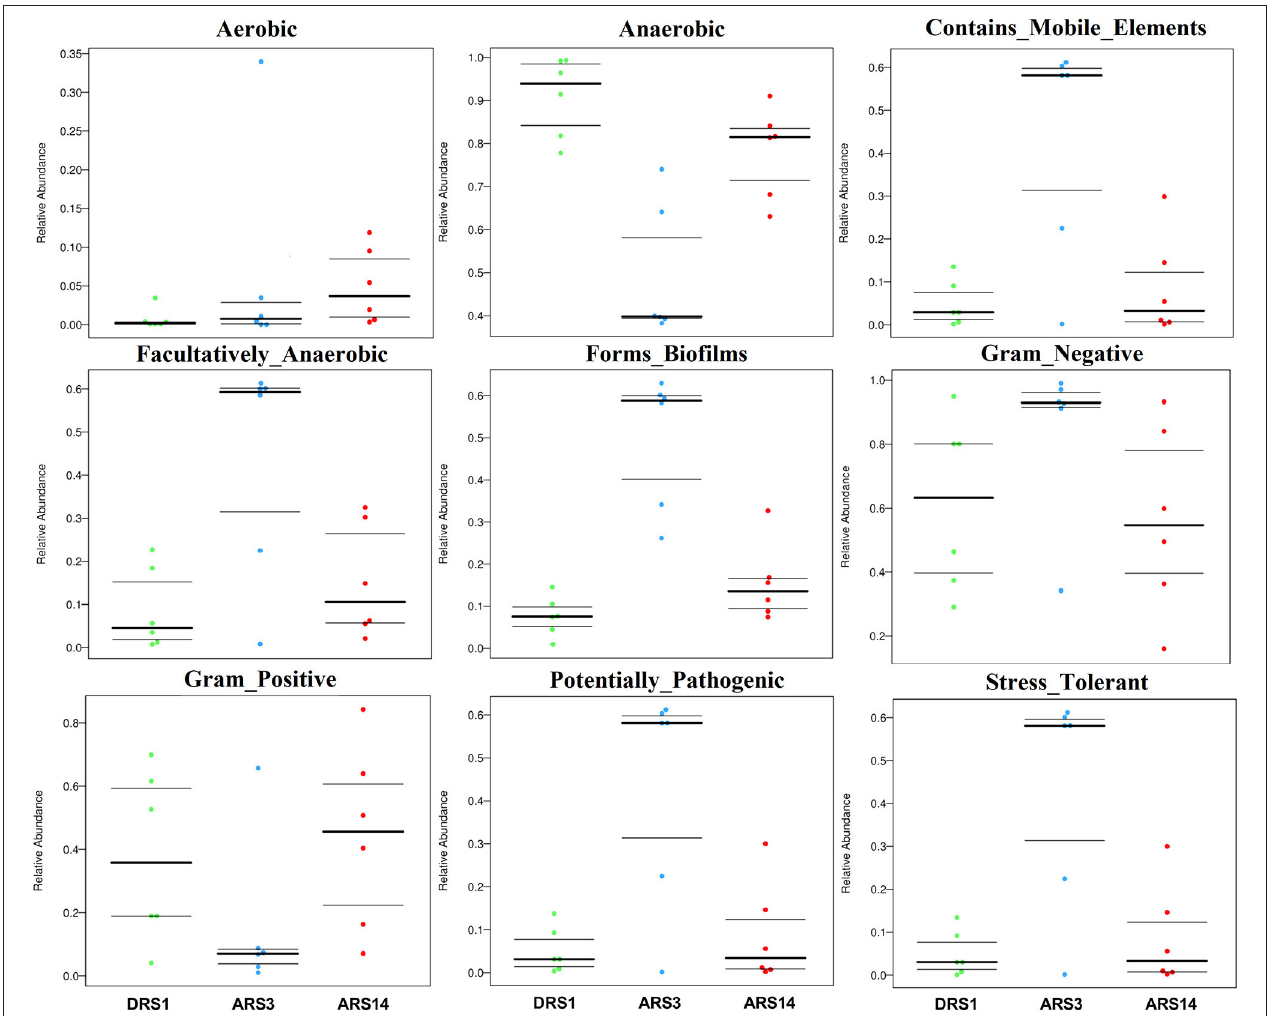
FIGURE 3 | BugBase feature prediction include aerobic, anaerobic facultative anaerobic, contains mobile element content, potential pathogenicity, stress tolerance, forms biofirms and gram-negative feature. DRS1 , 1d during the rumen surgery; ARS3 , 3d after the rumen surgery; ARS14, 14d after the rumen surgery; f_: family, taxonomic unit. The datas are accessible in https://www.ncbi.nlm.nih.gov/,